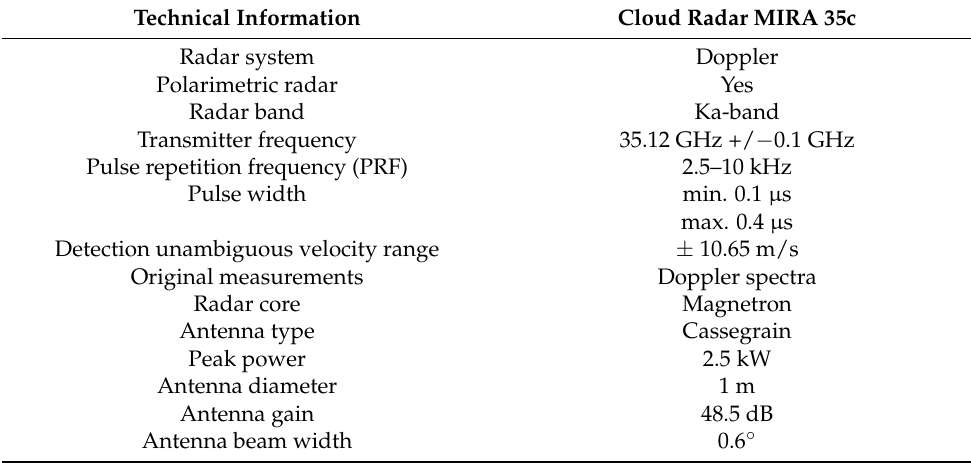
Table 1. Basic technical information on the cloud radar MIRA 35c situated at the Milešovka